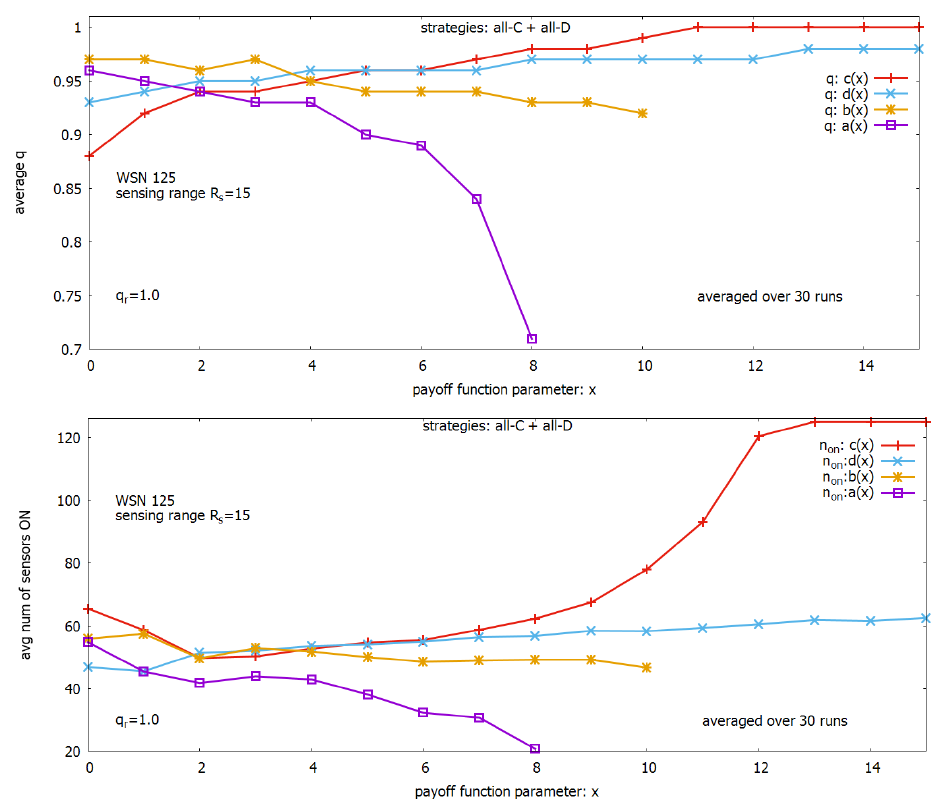
Figure 6. Influence of parameters of payoff function on: coverage q ( upper ), a number of sensors turned on ( lower